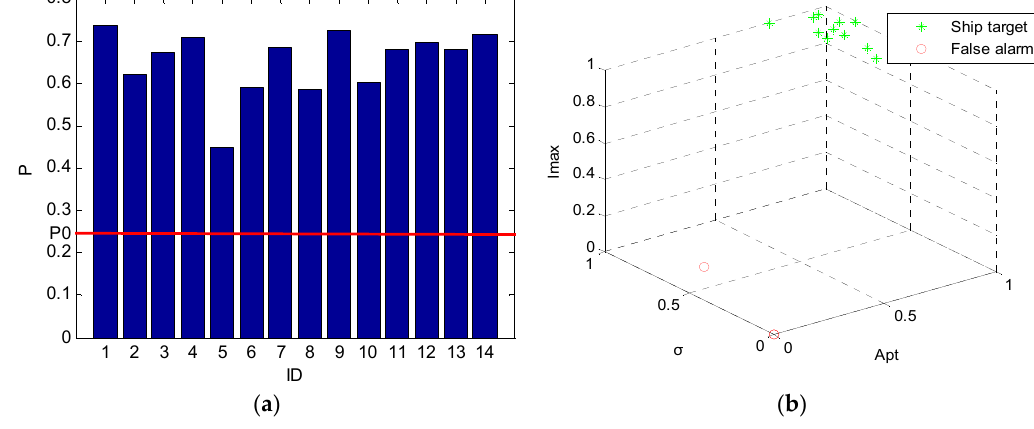
Figure 16. Confidence probabilities ( a ) and discrimination results ( b ) for test image ID 6.